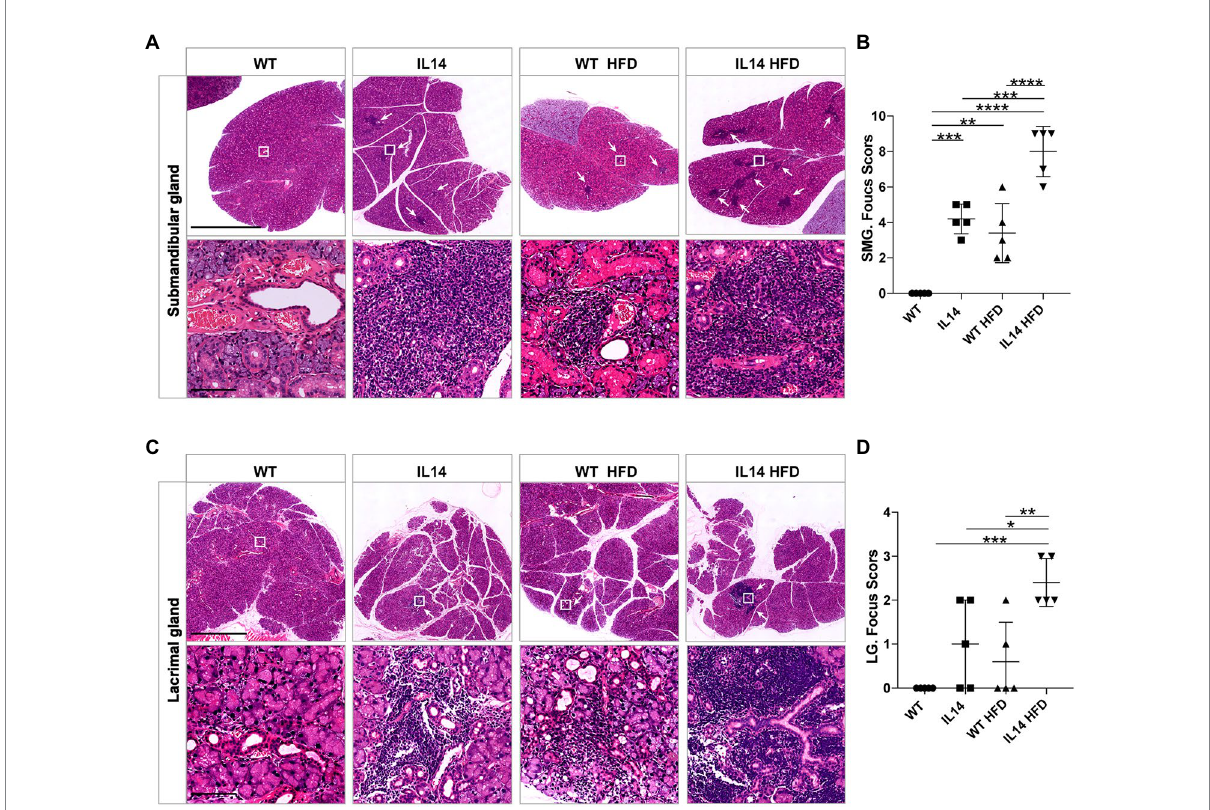
FIGURE 3 HFD exacerbated submandibular and lacrimal glands inflammation in the IL-14 α TG mice. SMG and LG tissues from the WT, IL14, WT HFD, and IL14 HFD groups were isolated for analysis. SMG (A) and LG (C) sections were stained with H&E, and representative images are shown. (B,D) Focus score of SMG and LG was quantified as described in the section “Materials and Methods,” showing a significant increase in infiltration after HFD. * p ≤ 0.05; ** p ≤ 0.01; *** p ≤ 0.005; and **** p ≤ 0.001; n = 5 per group. SMG, Submandibular gland; LG, Lacrimal gland. Scale bars: 2.5 mm for H&E staining of SMG, 100 μ m for enlarged images of SMG, 1 mm for H&E staining of LG, and 100 μ m for enlarged images of LG. White arrowheads indicate the site of lymphocyte